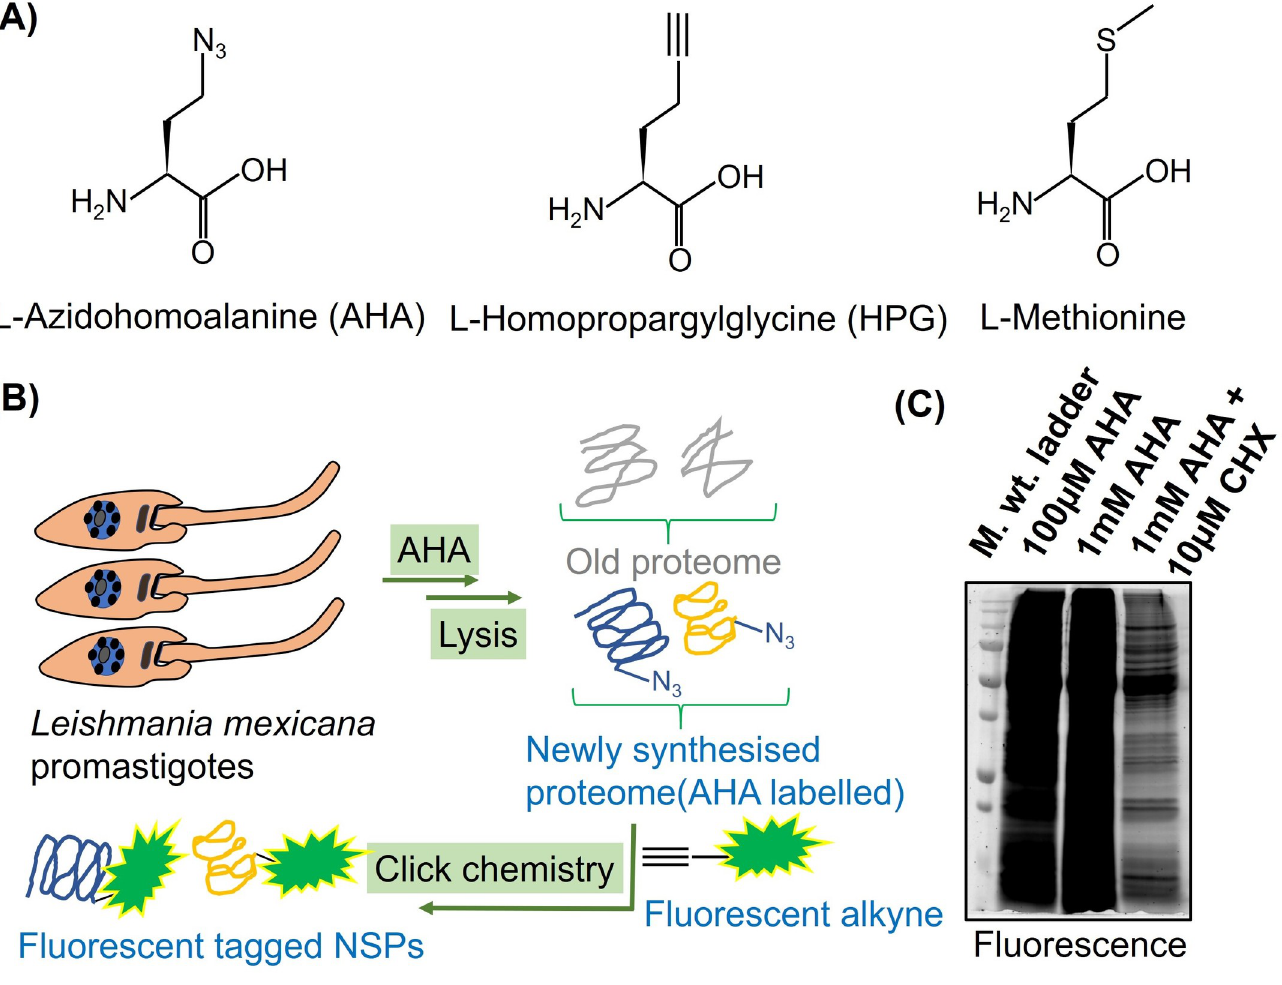
Fig 1. BONCAT in L . mexicana promastigotes. ( A ) Chemical structure of AHA, HPG and Methionine. ( B ) Workflow for BONCAT in L . mexicana promastigotes. AHA that can be bioorthogonally tagged with a fluorescent terminal alkyne was used for the BONCAT. ( C ) Fluorescent labelling of the NSPs following BONCAT detected by in-gel fluorescence